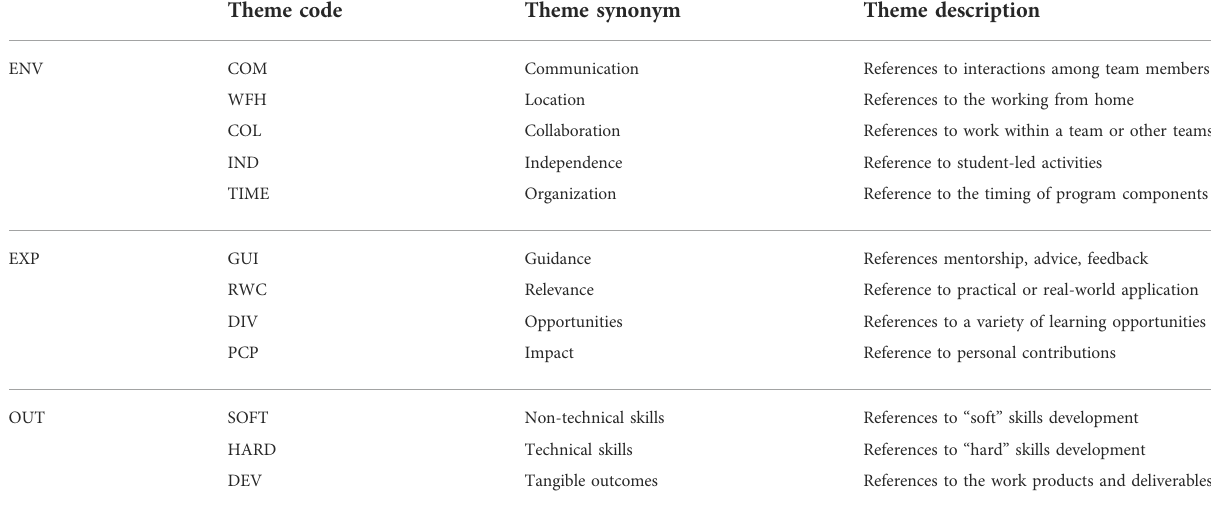
TABLE 1 Participant responses to open-ended questions were analyzed by associating each answer to one or more recurring themes assigned a uniquecode,synonym,anddescription.Therecurrentthemesareassociatedwiththelearningexperience(EXP),thelearningenvironment(ENV), and the learning outcomes